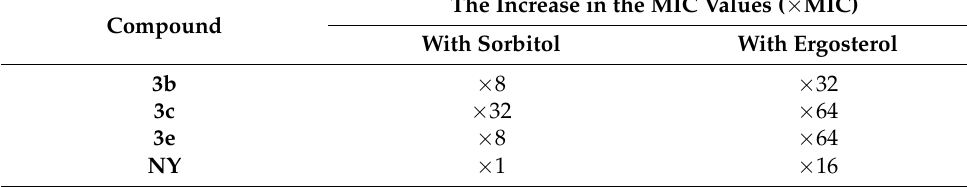
Table 7. The increase in the MIC values ( × MIC) of compounds in the presence of sorbitol (0.8 M) and ergosterol (400 µ g/mL) against C. albicans ATCC 10231. The standard antibiotic—nystatin (NY) was used as control. The Increase in the MIC Values ( × MIC) Compound With Sorbitol With Ergosterol 3b × 8 × 32 3c × 32 × 64 3e × 8 × 64 NY × 1 ×